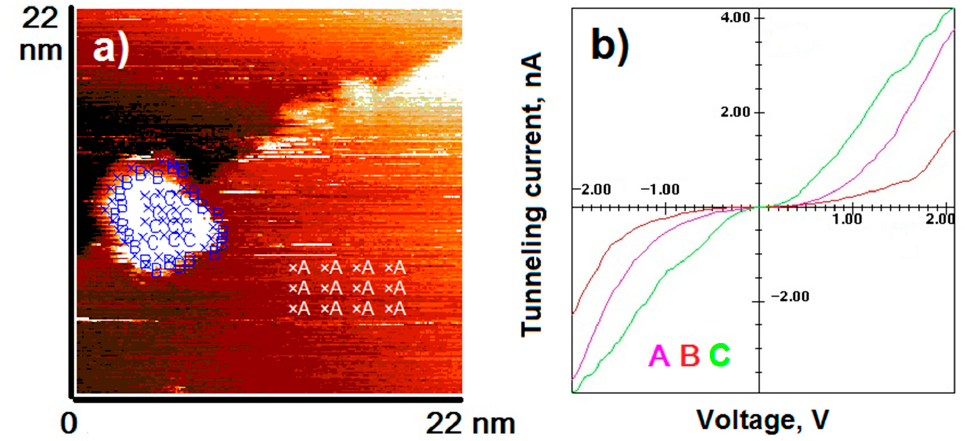
Figure 2. HOPG-supported gold nanoparticle after 200 L exposure to hydrogen: ( a ) topography image of the HOPG surface area with nanoparticle, ( b ) averaged VAC curves corresponding to the points indicated on the topography image. Curve A—area of graphite without nanoparticles; curve B—peripheral area of the nanoparticle; curve C—central area of the nanoparticle.